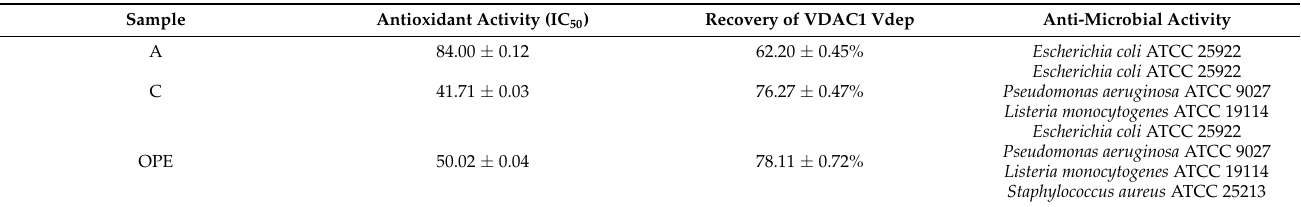
Table 5. Comparison of the antioxidant activity, voltage-dependence recovery and anti-microbial activity of each tested sample.